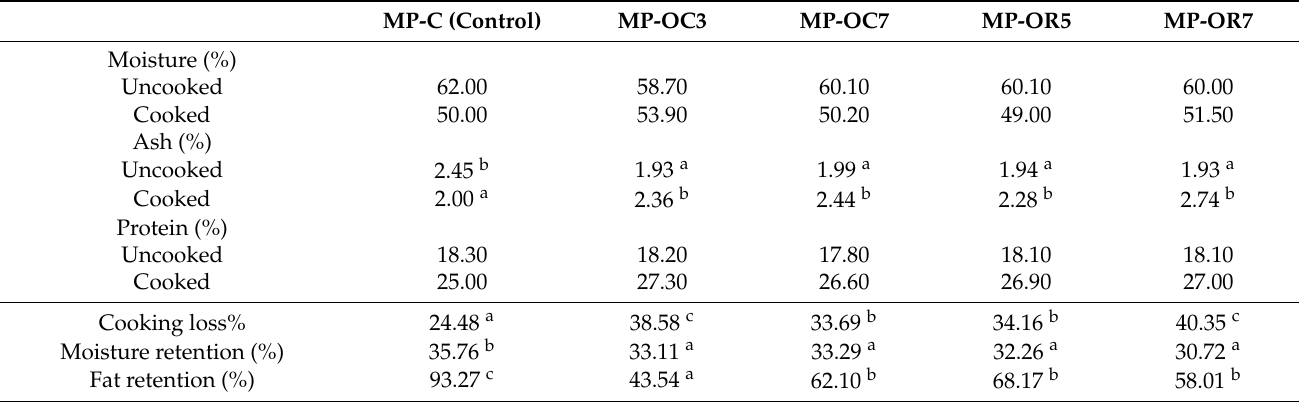
Table 3. Proximate analysis and technological properties of uncooked and cooked meat